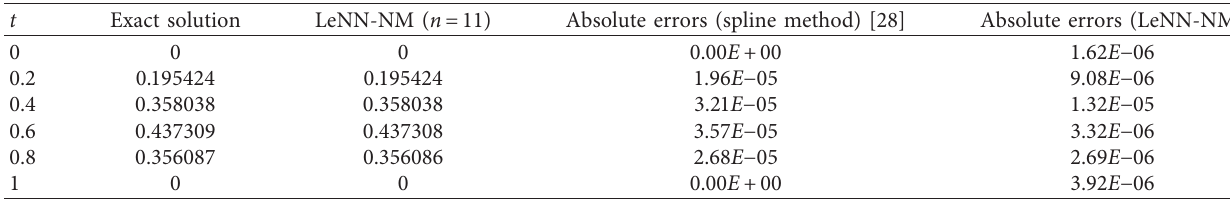
Table 2: Comparison of approximate solutions obtained by LeNN-NM algorithm with the exact solution and spline method [28] along with absolute errors for Problem 2.